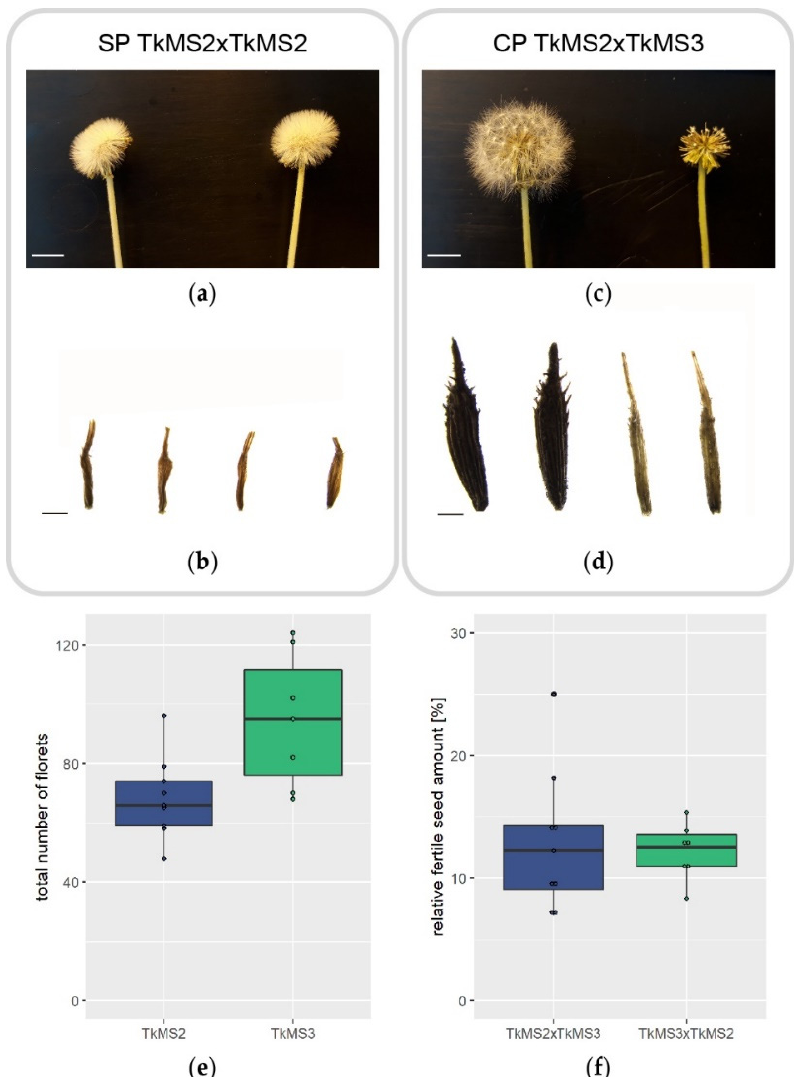
Figure 1. Overview of Taraxacum koksaghyz flower and seed morphology 12–14 days after incompatible and compatible pollination and the analysis of florets and seeds. ( a ) Following self-pollination (SP), variety TkMS2 did not produce spherical seed heads, indicating ( b ) the production infertile seeds. TkMS2 is shown as a representative example but similar results were obtained for TkMS3. The irregular shape and small size of infertile seeds was consistent with incompatible pollination. ( c ) A dandelion-typical achene was formed following cross-pollination (CP) with TkMS3 as the pollen donor. The upper part of the stalk was removed before the fertile seeds reached maturity to visualize the seeds. ( d ) Fertile (left) and infertile (right) seeds from the CP TkMS2xTkMS3. The pappus was detached prior to the formation of the seed head (8–10 days after pollination). The infertile and fertile seeds originating from the compatible pollination were similar in length but differed in shape and thickness. ( e ) The total number of florets within the flower head of TkMS2 (n = 9) and TkMS3 (n = 7) were counted and ( f ) the relative fertile seed set of compatible pollinations were calculated. Scale bars in ( a , c ) = 10 mm and in ( b , d ) = 0.5 mm.